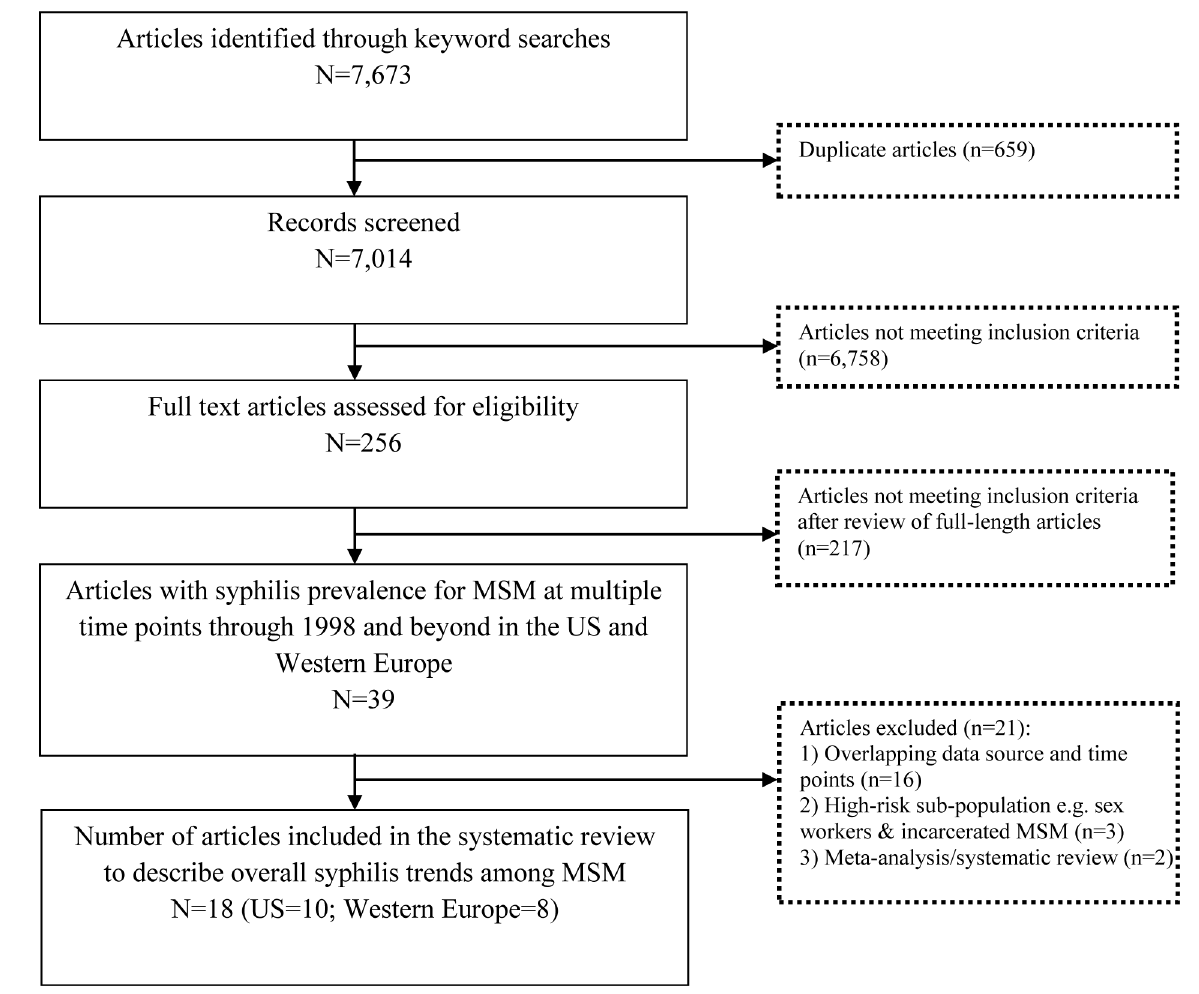
Fig 1. Flow diagram showing the article screening